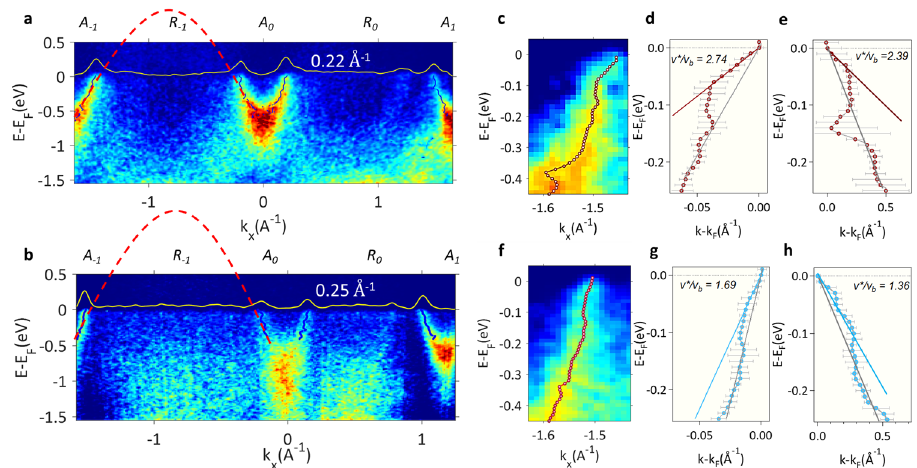
Fig. 2 Quasi-two dimensional hole bands and their dispersion kinks. a , b Angle-resolved photoelectron spectroscopy images recorded at the energy hv = 708 eV and p-polarized light along the RAR direction, probing the hole bands for La 0.7 Sr 0.3 MnO 3 (LSMO) surface ( a ), and for PbZr 0.2 Ti 0.8 O 3 (PZT) interface PZT|LSMO ( b ). The dots superimposed on each image are the momentum distribution curve (MDC) maxima, with the MDCs at E F (yellow lines) used to extract the Fermi wavevector (k F ) values. The dashed lines are guides for the eyes indicating the hole band. c Zoom into the low-energy region of the experimental band structure around A − 1 point for LSMO bare surface. The superimposed dots are the MDC maxima which identi fi es the kinks in the parabolic dispersion of the hole bands. d , e MDC maxima and their linear fi ts corresponding to the bare and renormalized dispersions in the kink region for LSMO surface interface around two different points of the Brillouin zone: A − 1 ( d ) and A 1 ( e ). f Zoom into the low-energy region of the experimental band structure around A − 1 point for PZT|LSMO interface. g , h MDC maxima and their linear fi ts corresponding to the bare and renormalized dispersions in the kink region for PZT|LSMO interface around two different points of the Brillouin zone: A − 1 ( g ) and A 1 ( h ). The error bars represent the standard deviation extracted from the MDC fi t with a combination of Lorenz distribution and smooth background.